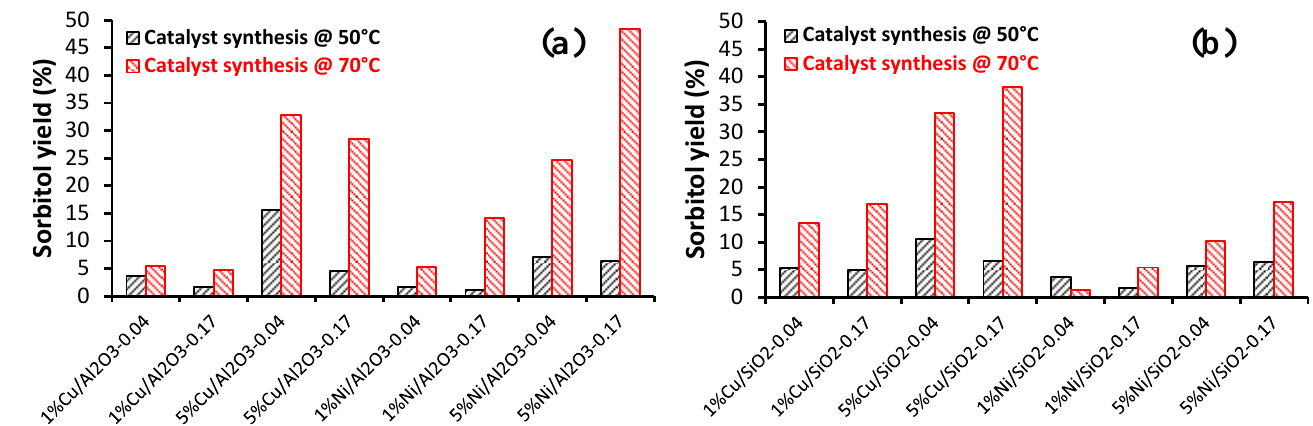
Figure 8. Sorbitol yields with ( a ) alumina-supported and ( b ) silica-supported catalysts synthesized at temperatures of 50 and 70 °C. (Test conditions: catalyst amount = 10 mg; 3 mL of glucose solution (1 wt.%); T = 130 °C; P H2 = 30 bar; t = 4 h). Adapted with permission from Ref. [48].